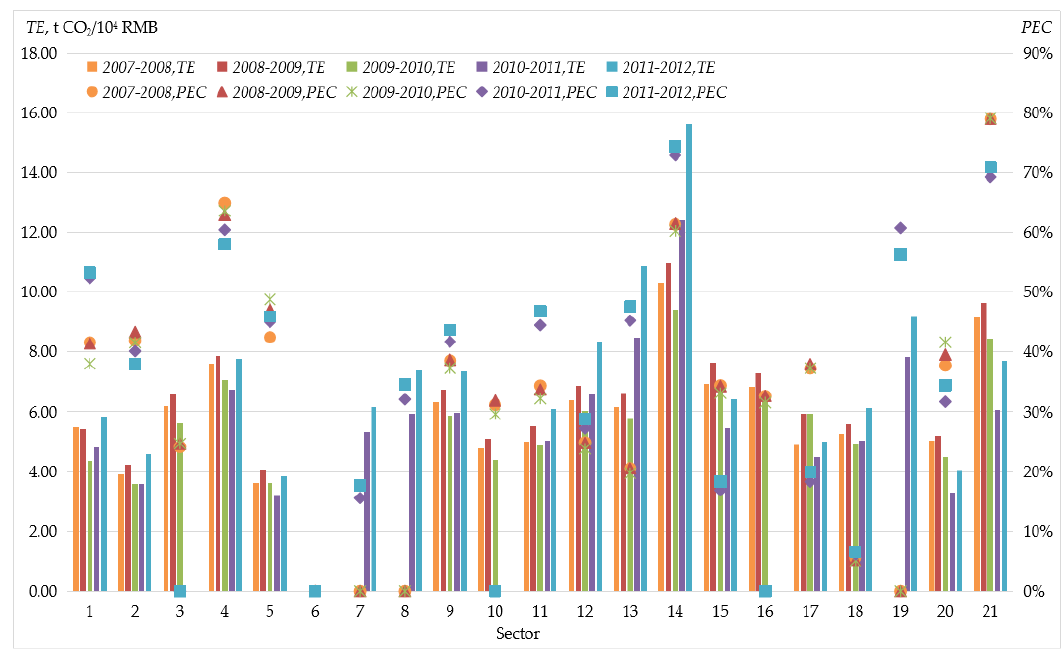
Figure 3. TE (left coordinate axis, bar) and the PEC (right coordinate axis, point) caused by a unit increase of sectoral FDEI.